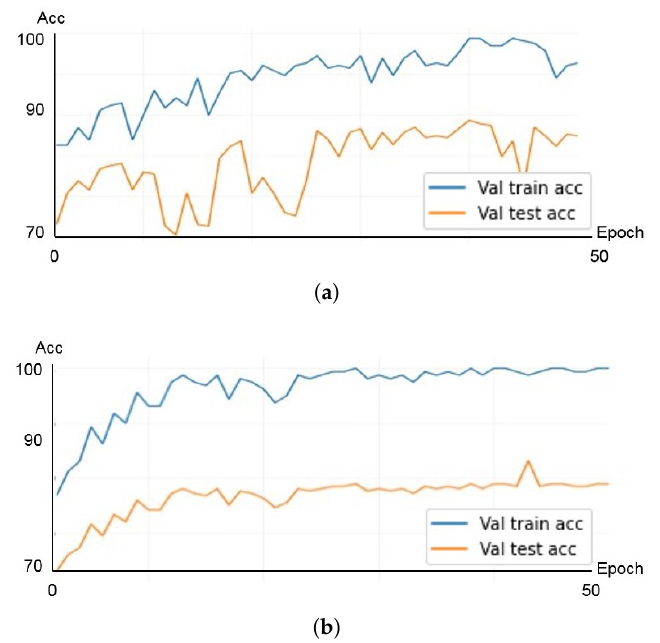
Figure 5. Results of validation experiment. ( a ) ResNet50 model; ( b ) ResNet18